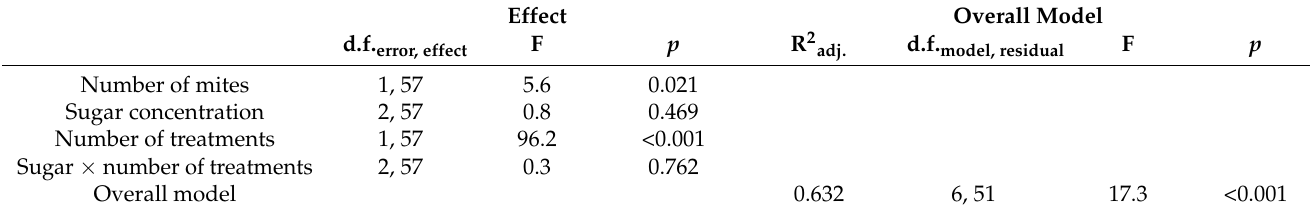
Figure 2. General linear model analysis considering the influence of the number of mites (covariate) on treatment efficiency via the ANCOVA (homogeneous slope) design revealed that efficiency (mean ± SD) of anti- Varroa LiCl treatments did not vary with the sugar concentration of the trickling solution. In contrast, repeated treatments proved to be more efficient than single treatments (for statistics, see Table 4). Plotted values marked with different letters are statistically different at p < 0.05 (Tukey HSD post hoc test). Table 4. General linear model analysis considering the influence of the number of mites (covariate) on treatment efficiency via the ANCOVA (homogeneous slope) design revealed that the efficiency of anti- Varroa LiCl treatments did not vary with the sugar concentration of the trickling solution, whereas it differed between single and repeated treatments. Results of Tukey HSD post hoc tests are shown in Figure